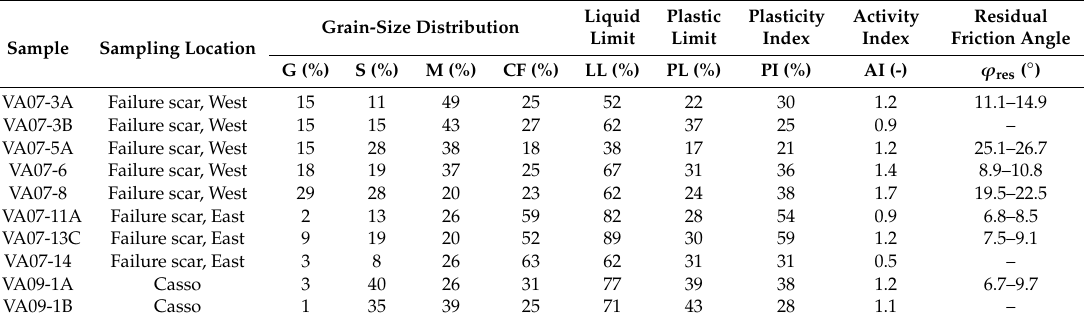
Table 3. Geotechnical index properties and residual friction angles of clay samples from Vajont.